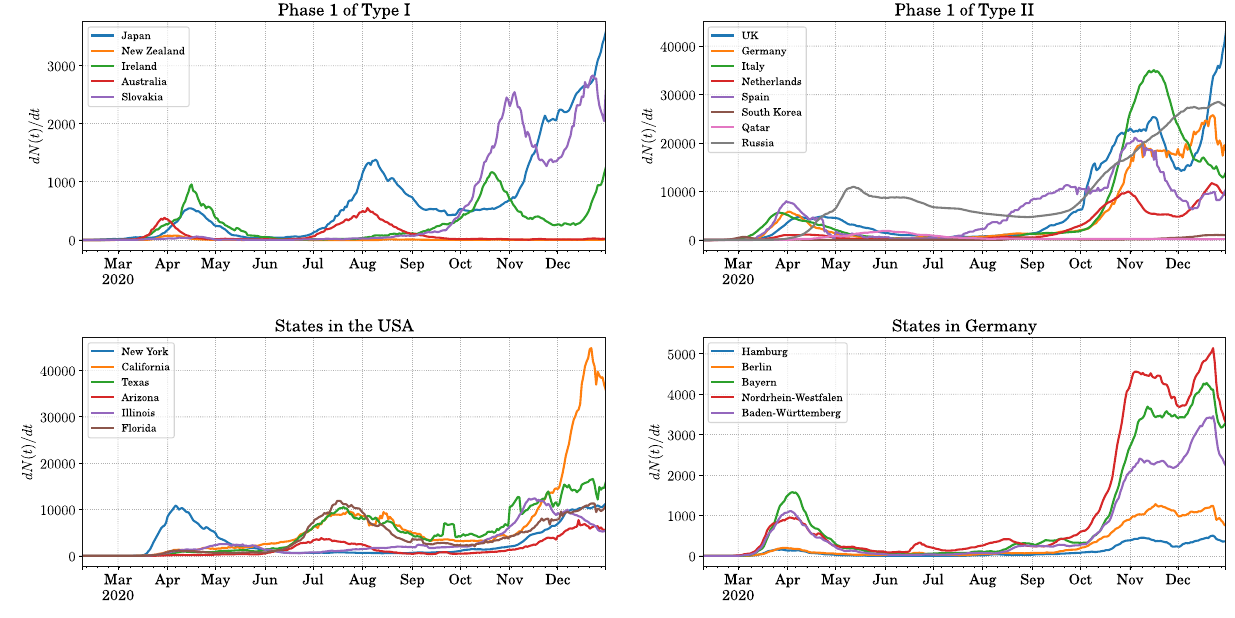
Figure 1. The variation in the spreading of COVID-19 in various countries and some states of the USA and Germany. Top left: the countries for which the first phase of spreading falls into the category defined as Type I. Top right: the countries for which the first phase of spreading falls into the category defined as Type II. Bottom left: some states in the USA that show very different spreading patterns for the disease. Bottom right: some states in Germany that show very similar pattern in the spreading of